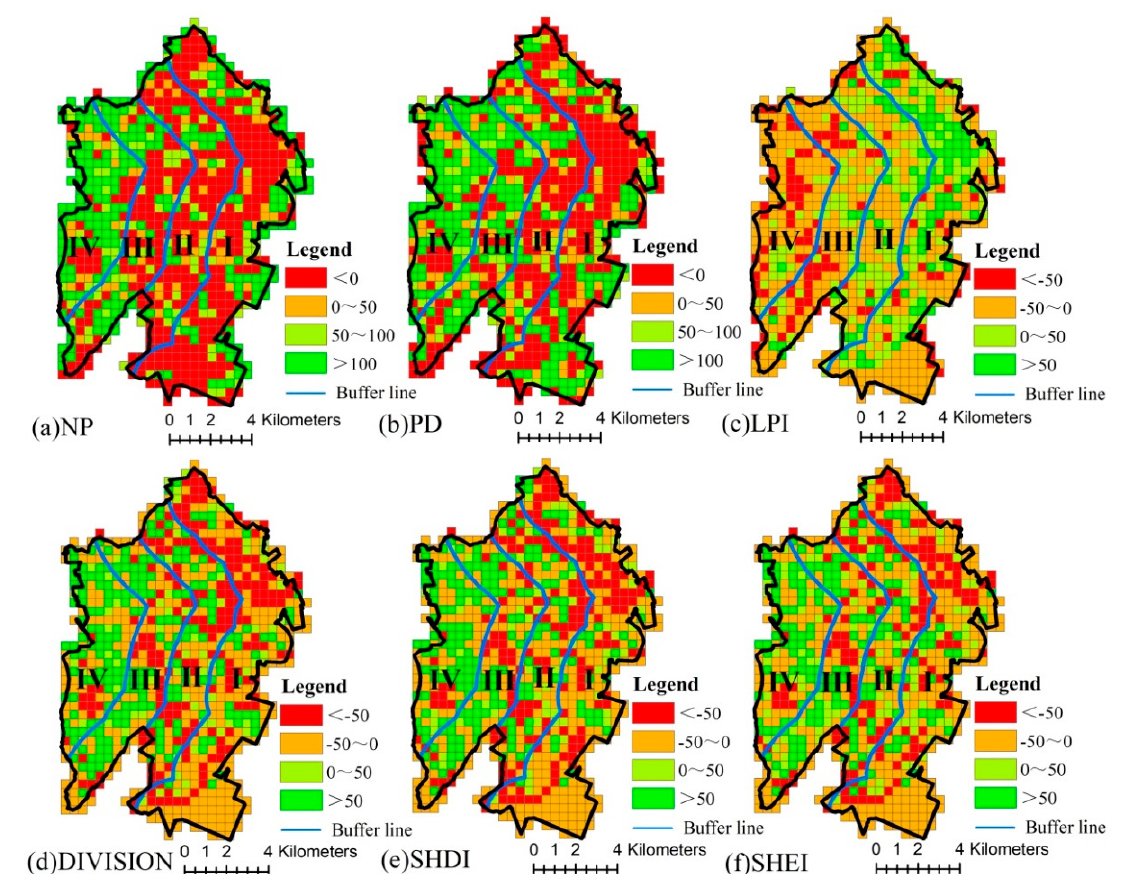
Figure 6. Spatial pattern of landscape metric variations from 2005 to 2020. (Gradient I (0–2 km), gradient II (2–4 km), gradient III (4–6 km) and gradient IV (>6 km) from the coastline to the inland).